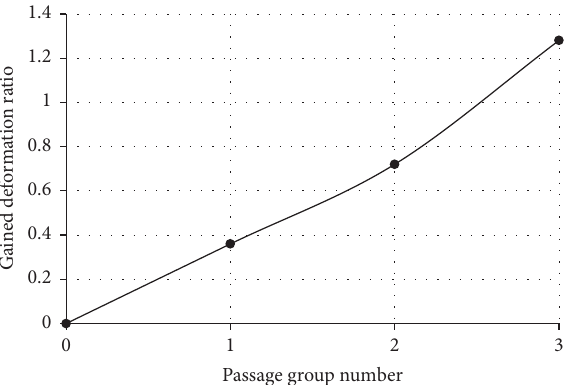
Figure 9: Te change in the accumulated logarithmic degree of deformation at the second stage of billet rolling after TE from the passage group: rolling temperature range is 350 ° C–200 ° C; there are 2 reductions from one heating in the passage group; change in the billet thickness during rolling is 9.0–2.5mm.